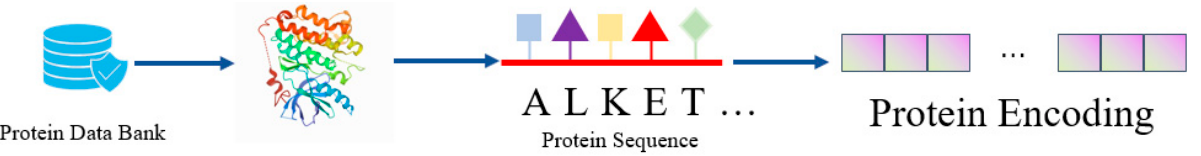
Figure 9. The process of protein encoding. Conversion of protein sequences of different lengths into fixed ‐ length vectors.